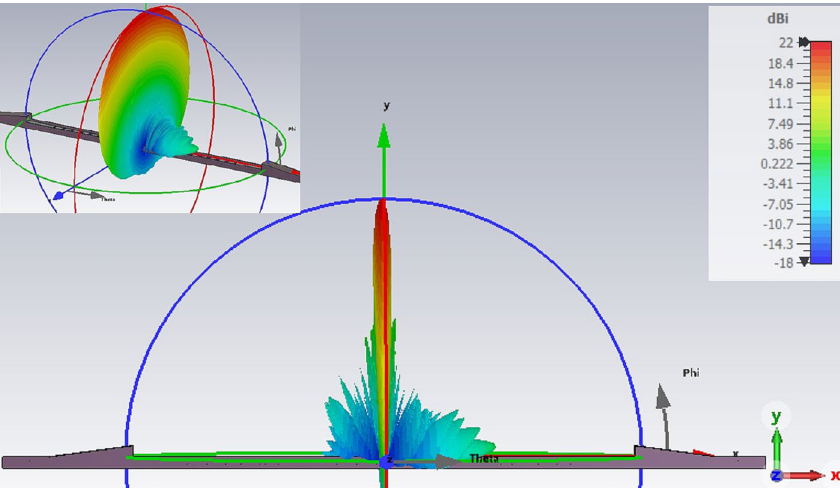
Fig. 11 3D radiation pattern at frequency F = 37.2 GHz (RP: 22 dBi, width of RP: 3.2 ◦ , Side lope: for antenna with non-identical